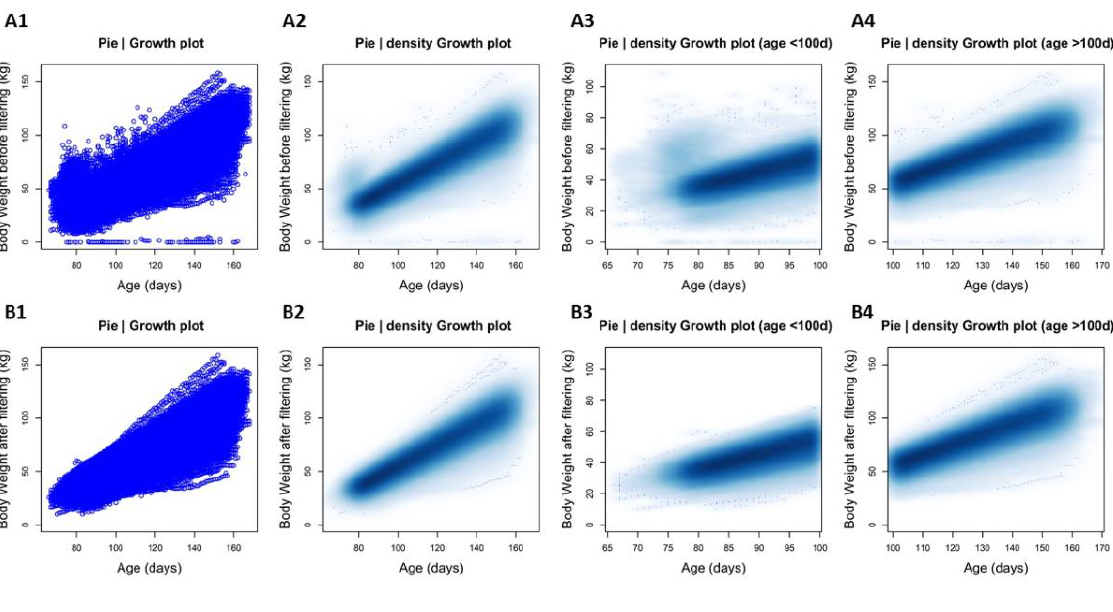
Figure 1 . Comparison of body weight density plots before (A) and after (B) applying data cleaning procedure in Pie line. In A1 and B1 plots each point represent the median of the individual daily body weight registered by the AFS during the pig fattening period. A2 and B2 are smoothed color density representations of a scatterplot. Shaded areas are constructed to illustrate the density of points falling into each part of the plot allowing for an intuitive visualization of very large datasets. A zoom in the density scatter plot before (A3-B3) and after (A4-B4) 100 days of individual age is illustrated.